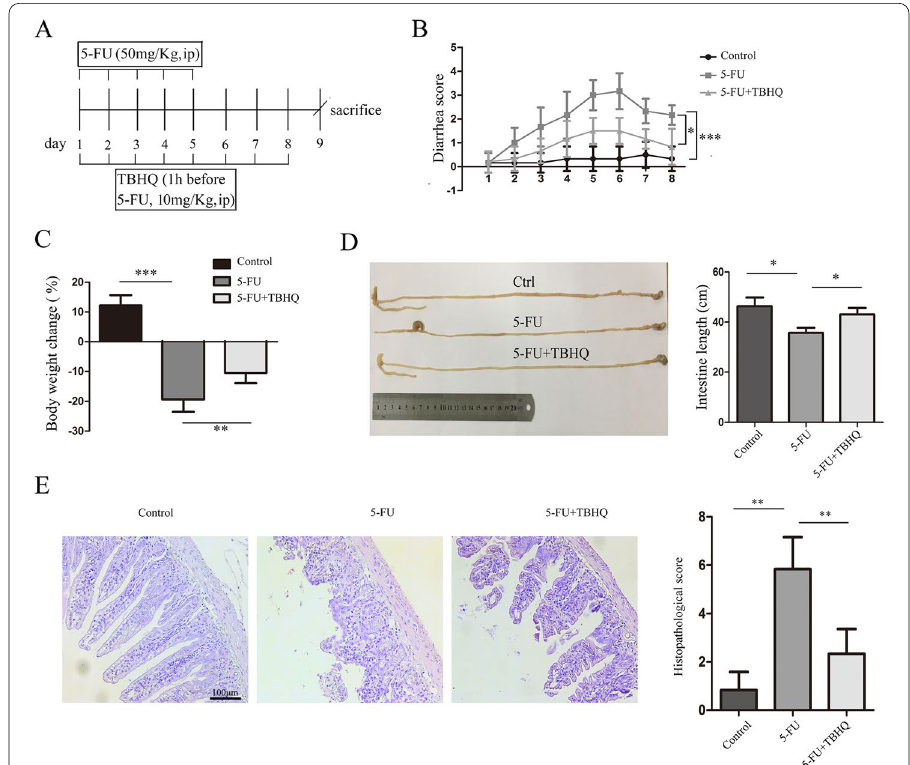
Fig. 2 TBHQ attenuates 5-FU-induced intestinal mucositis in mice. A Schedule for the administration of TBHQ on 5-FU-induced intestinal mucositis in mice. TBHQ (10 mg/kg body weight in DMSO, i.p.) or vehicle (DMSO, i.p.) was administered from day 1 to day 8, and 5-FU (50 mg/kg body weight, i.p.) or vehicle (saline, i.p.) was administered from day 1 to day 5. Animals were Killed on day 9 (n 6 animals/group). B , C The body weight = B and diarrhea C were recorded daily. D The whole intestine length of mice in each group was measured. E Histological changes in the small intestine were assessed using hematoxylin and eosin (H&E) staining (ccale bars: 100 μm). *p < 0.05, **p < 0.01, ***p <